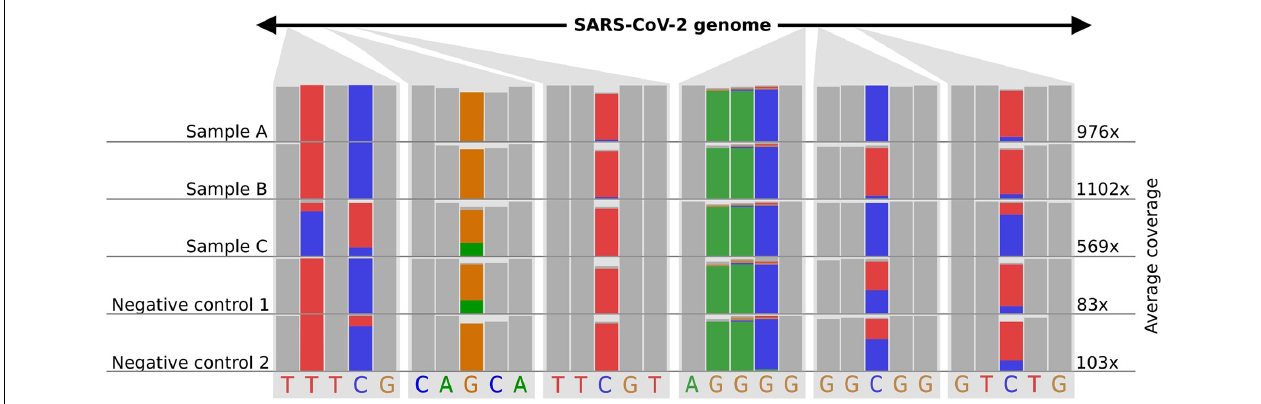
FIGURE 3 | Example of how sample-barcode bleeding can be identified by inspecting SNP proportions of false-positive negative controls in mapping (.bam) files. Three samples and two negative controls are shown. Each column shows the proportions of the bases (A-green, T-red, G-yellow, C-blue) that were found in all mapped reads for the respective position. A position where all the bases of the reads are the same is shown as a gray bar. The read coverage is noted on the right side of the figure. Library preparation for samples (A–C) was performed with too much DNA. Negative controls follow the same library preparation steps as the samples (A–C) but with pure water instead of viral amplicon DNA. Additionally, the library preparation for the negative controls was performed in a separate lab and with new reagents up until the barcode pooling. Negative controls indicate SNP proportions that roughly reflect sample (A–C) considering their average coverage. The schematic figure is adapted from